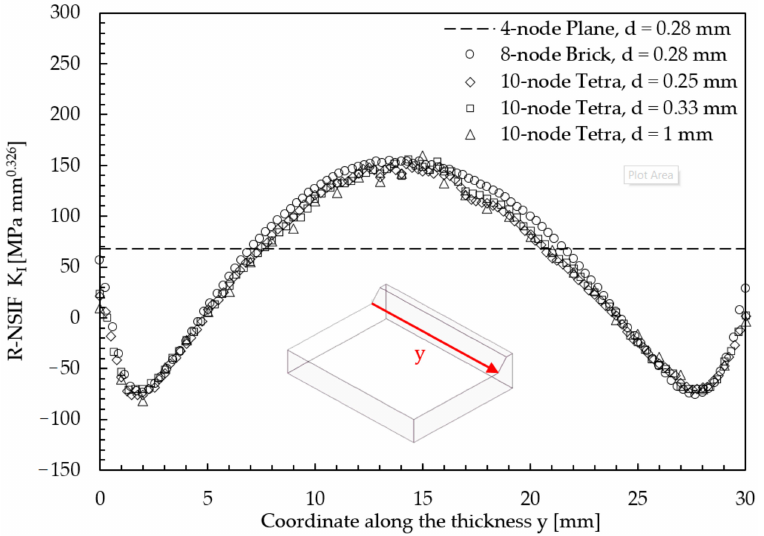
Figure 9. Comparison between R-NSIF distributions as a function of the element type and average element size d. The considered FE mesh patterns are reported in Table